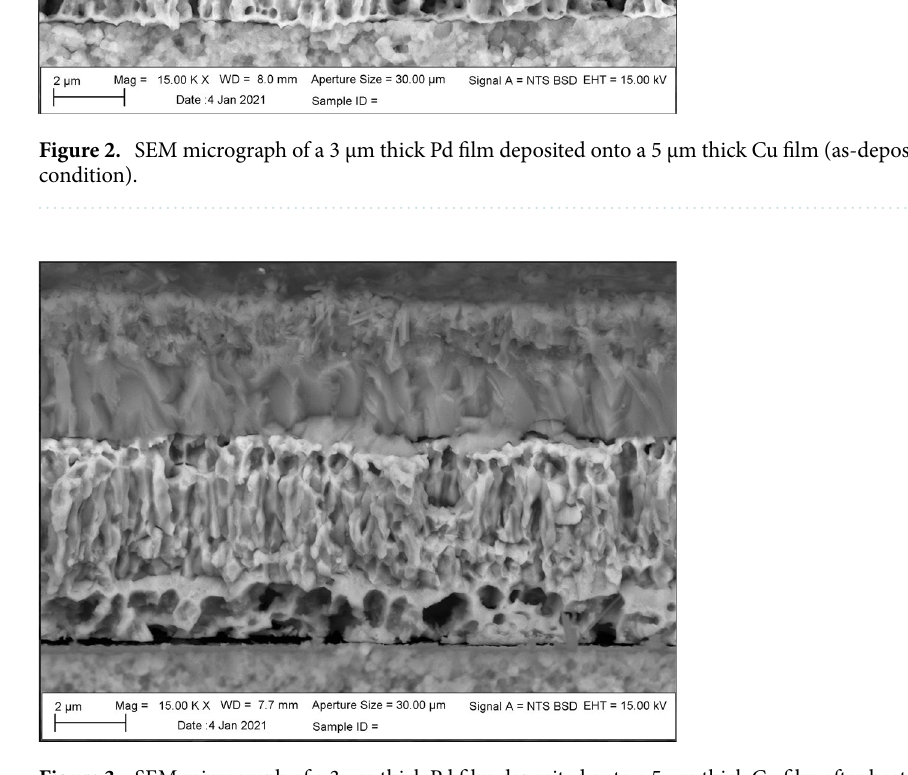
Figure 3. SEM micrograph of a 3 µm thick Pd film deposited onto a 5 µm thick Cu film after heating to 350